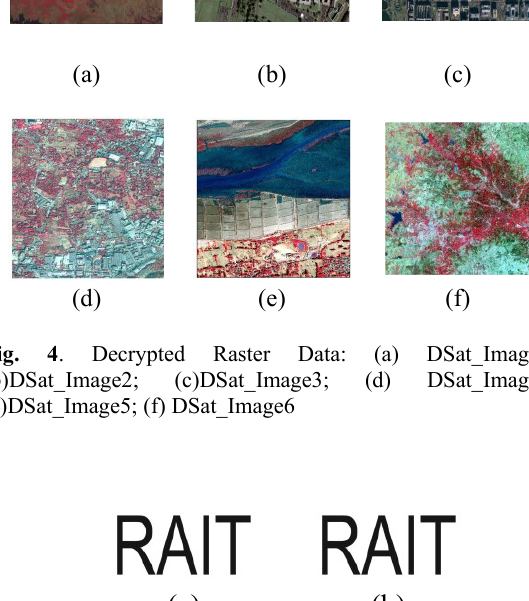
Fig. 5 . (a) Original Watermark, and (b) Extracted watermark with NC=1